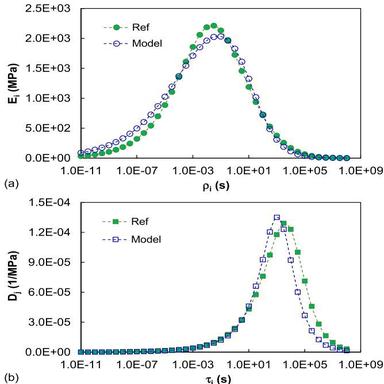
Prony discretization of the spectra with two points per decade: (a) relaxation spectra given by the 2S2P1D model, and (b) retardation spectra obtained from conversion.